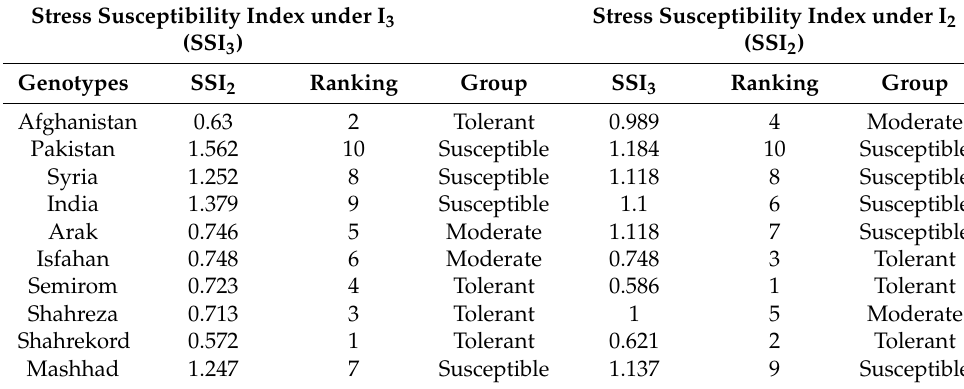
Table 11. Rankings of ten black cumin genotypes based on the stress susceptibility index of seed yield under irrigation after 60% depletion of available soil water (I 2 ) and under irrigation after 80% depletion of available soil water (I 3